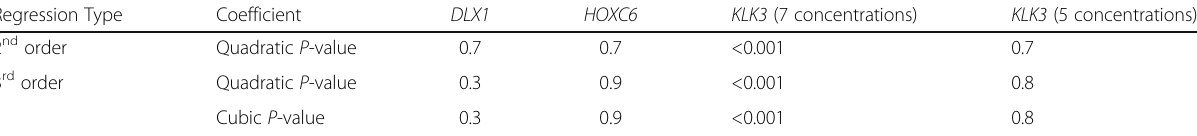
Table 4 P -values associated with the polynomial regression coefficients for the dilution series Regression Type